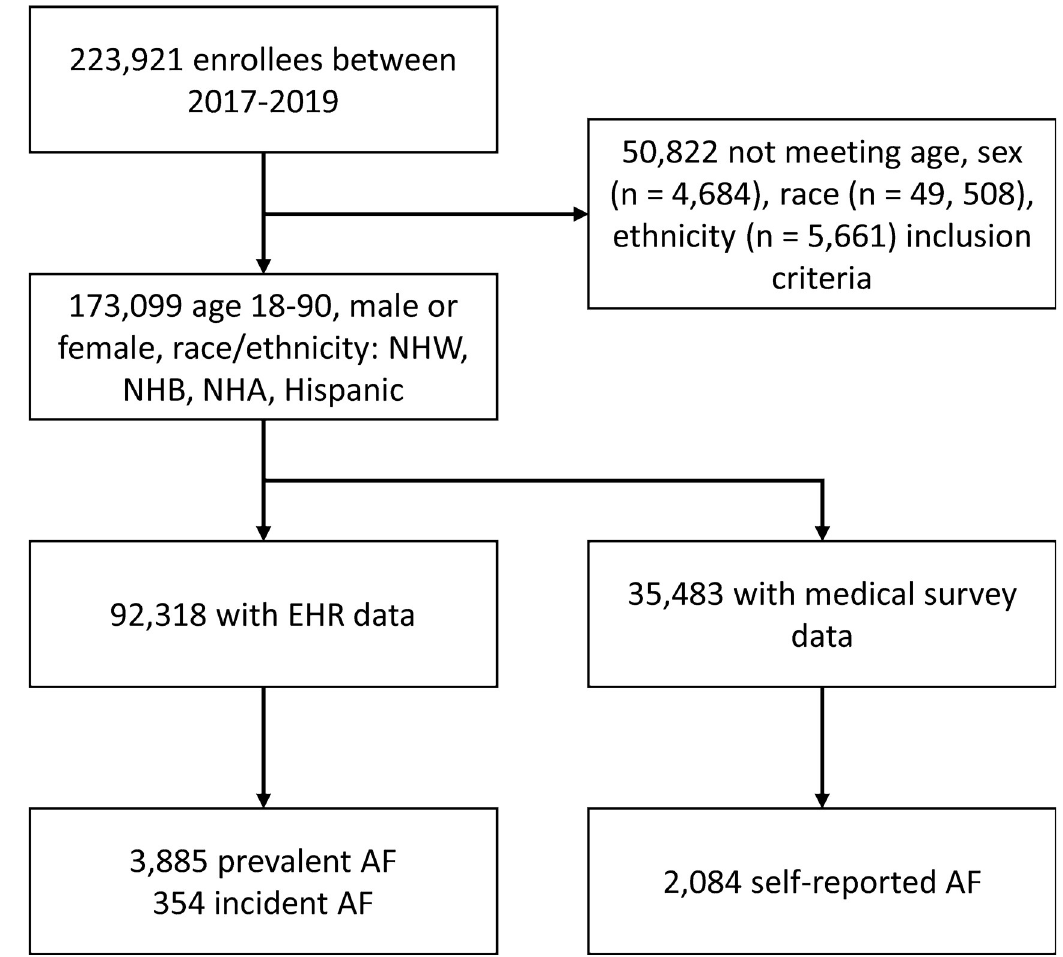
Fig 1. Flowchart of study participants, All of Us Research Program, 2017–2019. EHR: Electronic health records. NHA: Non- Hispanic Asian. NHB: Non-Hispanic Black. NHW: Non-Hispanic White. Characteristics of study participants by race/ethnicity are presented in Table 1 , while characteristics by participation in study components is provided in S2 Table . Approximately two thirds of participants were non-Hispanic Whites, with non-Hispanic Blacks, non-His- panic Asians and Hispanics accounting for 26%, 4%, and 3% of participants, respectively. Overall mean age (standard deviation) was 52 (17), and females accounted for 61% of all par- ticipants. Prevalence of most cardiovascular diseases and risk factors was highest in non-His- panic Blacks and lowest in non-Hispanic Asians (Table 1). Participants with both EHR and survey data were slightly older, more likely to be female and non-Hispanic White, and had lower prevalence of cardiovascular risk factors (smoking, diabetes) and cardiovascular diseases (stroke, heart failure, coronary heart disease) than those without data from the EHR or the medical history survey ( S2 Table ). Fig 2 presents the overlap in participants based on avail- ability of EHR and medical history data and diagnosis of AF. In the 20,683 participants with overlapping EHR and survey data, 1,486 had AF either from EHR or medical history survey, with 717 reported in both (48%), 208 in the EHR only (14%), and 561 in the medical survey (38%).